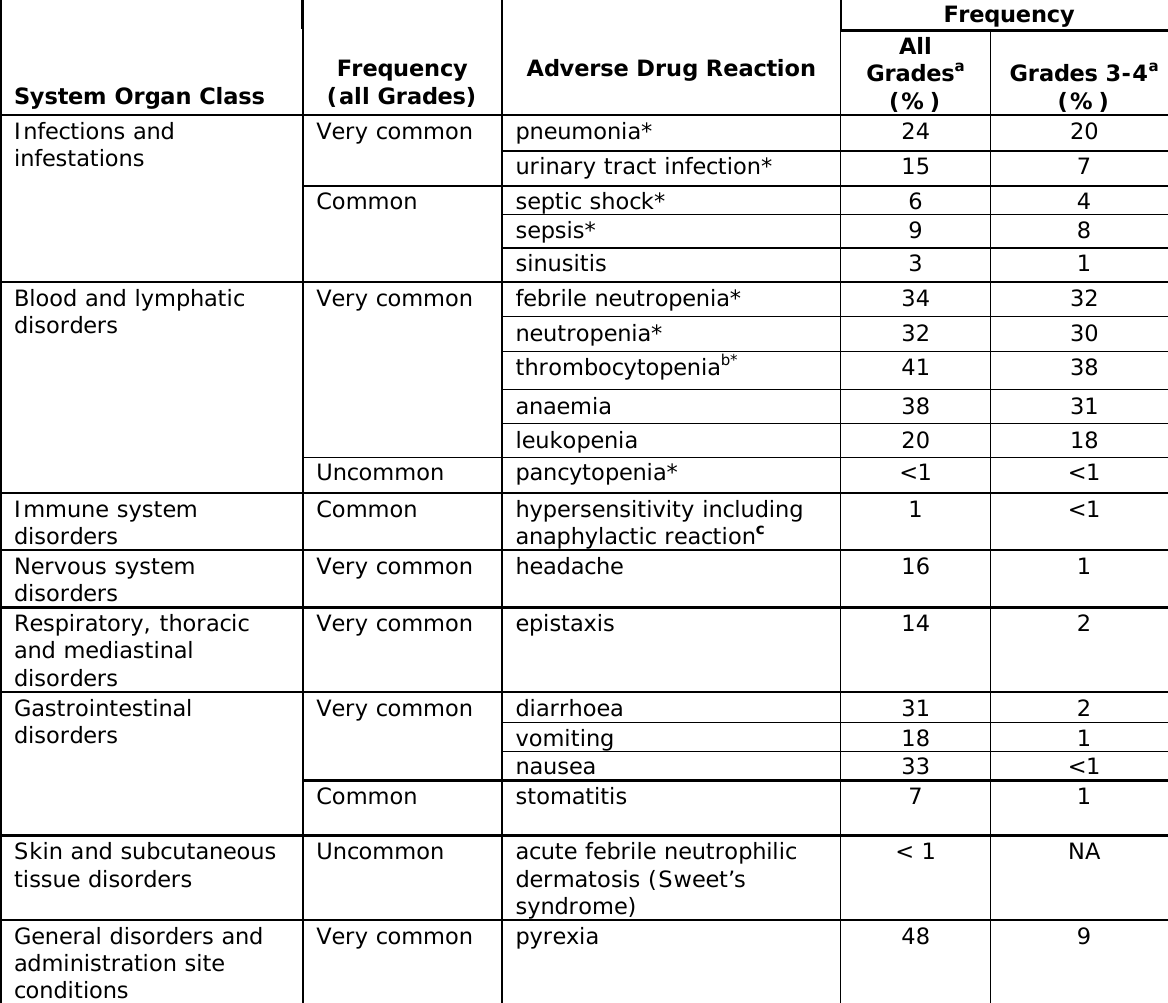
Adverse drug reactions identified with